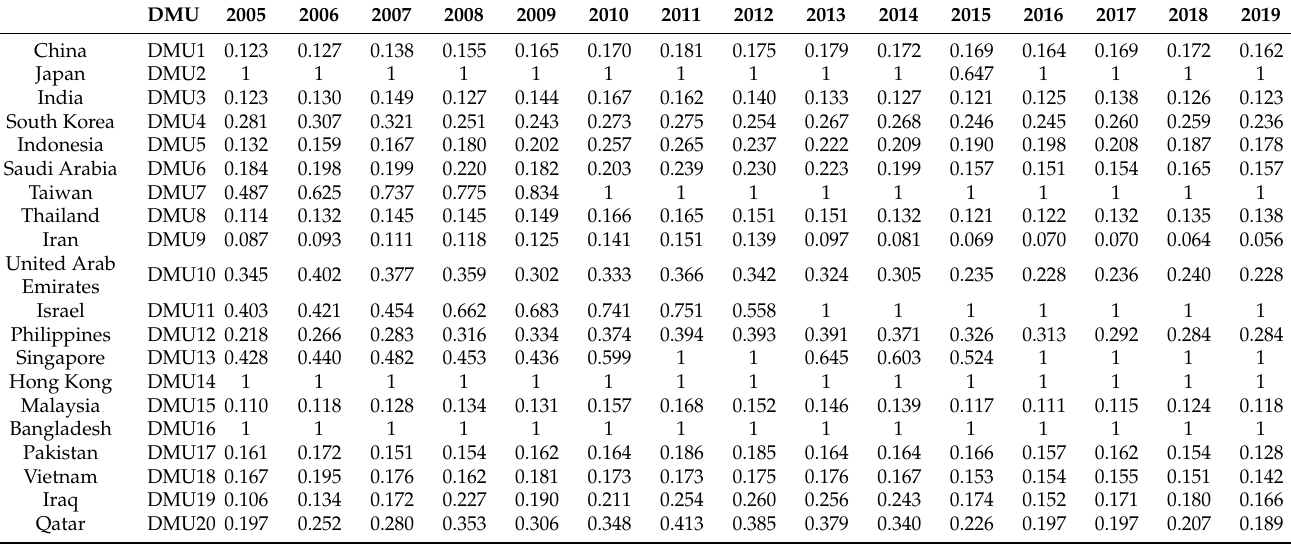
Table 5. Environmental efficiency data for the 20 top GDPs in Asia during the 2005–2019 period. Source: Authors’ estimation.